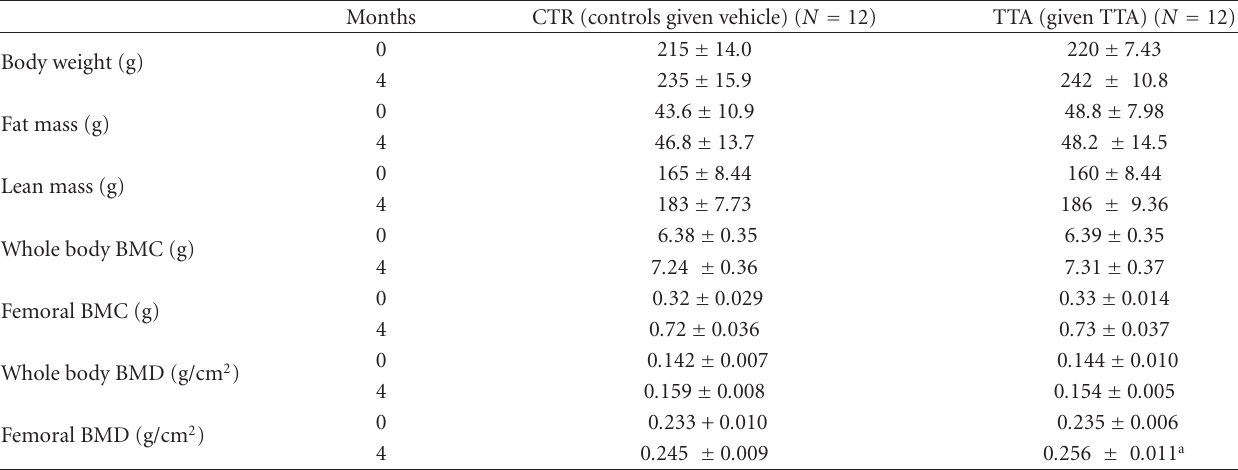
Table 1: Body weight, fat and lean mass, femoral and whole body bone mineral content (BMC), and bone mineral density (BMD) in rats at baseline and after four months of treatment with TTA (Study I).